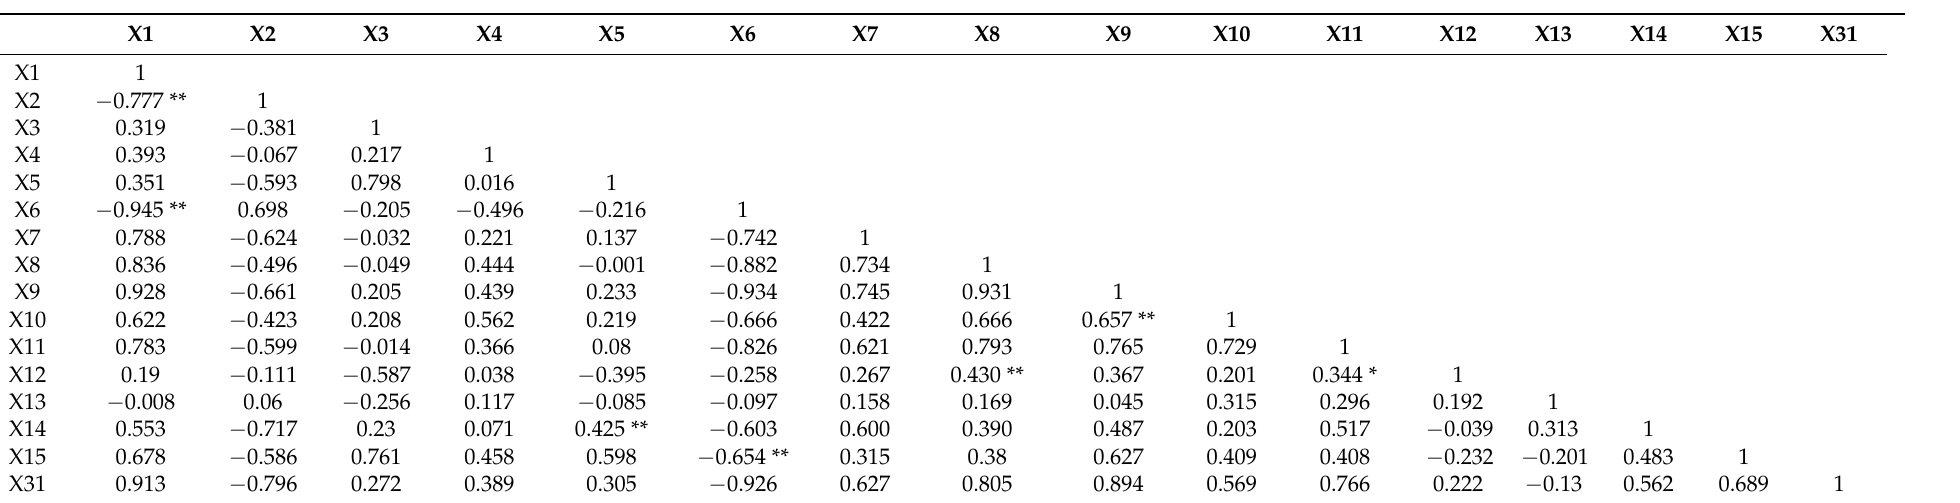
Table 2. Correlation analysis (CA) on quality